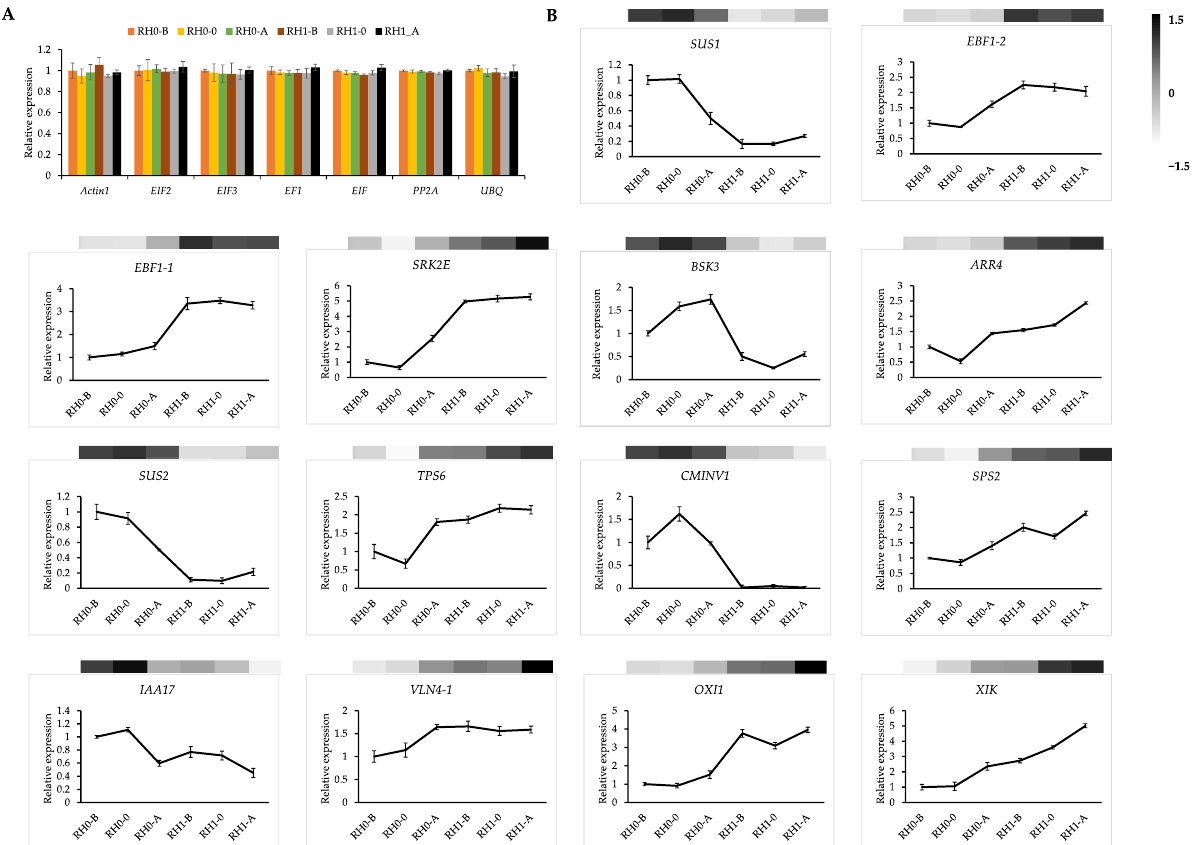
Figure 8. Expressions of 14 DEGs in hormone and sugar signal involved in root hair growth and development of A. beshanzuensis determined by qRT-PCR. ( A ) Expression stability of candidate reference genes of A. beshanzuensis determined by qRT-PCR. ( B ) Expressions of 14 DEGs in hormone and sugar signal involved in root hair growth and development of A. beshanzuensis determined by qRT- PCR. Error bars, standard deviation (SD) from three biological repeats.